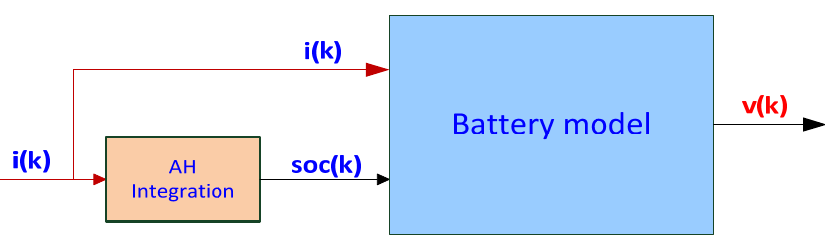
Figure 1. Open-loop battery